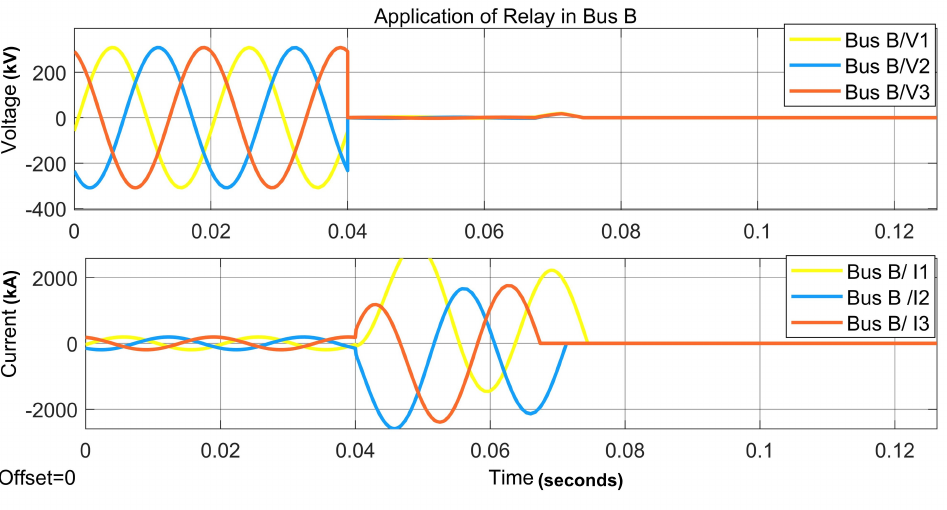
Figure 5. Application of relay at bus